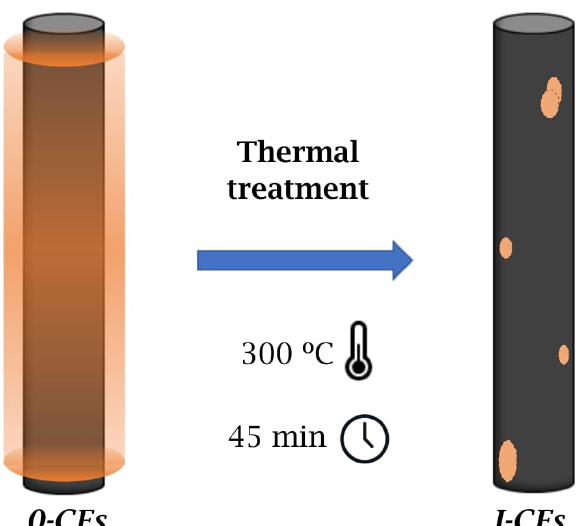
Figure 1. Schematic of thermal treatment. Commercial fibers and fabrics are classified as 0-CFs (untreated) or I-CFs (thermally treated).